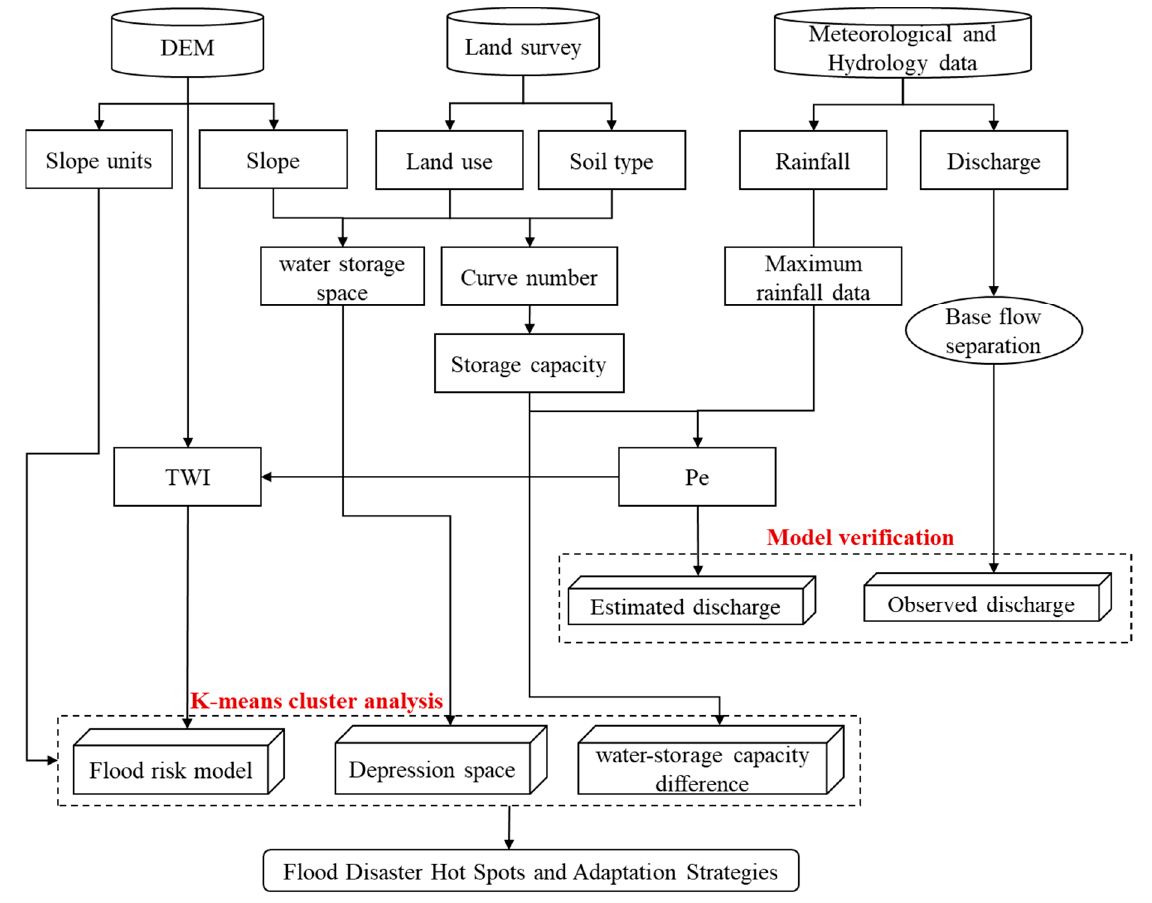
Figure 3. Study flow chart.